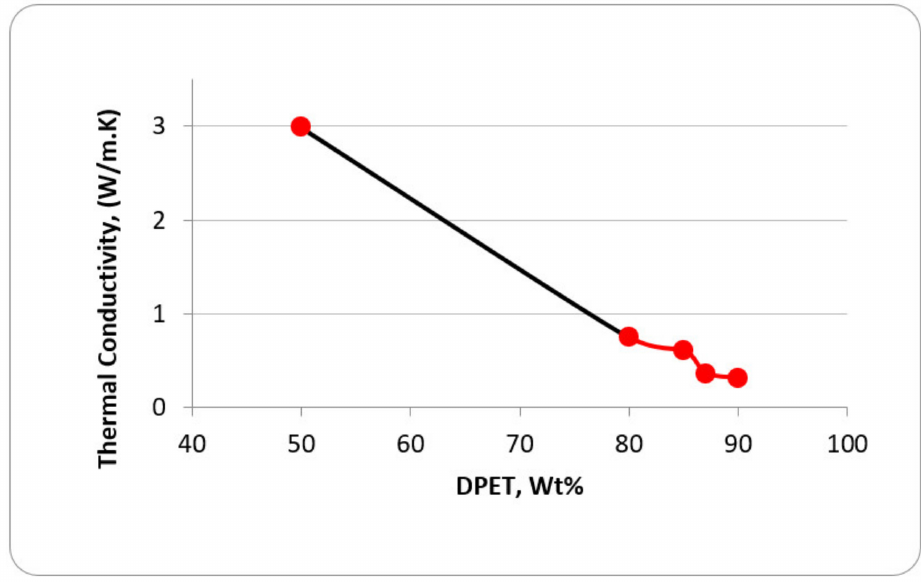
Figure 7. Thermal conductivity of composite coating with different percentages of